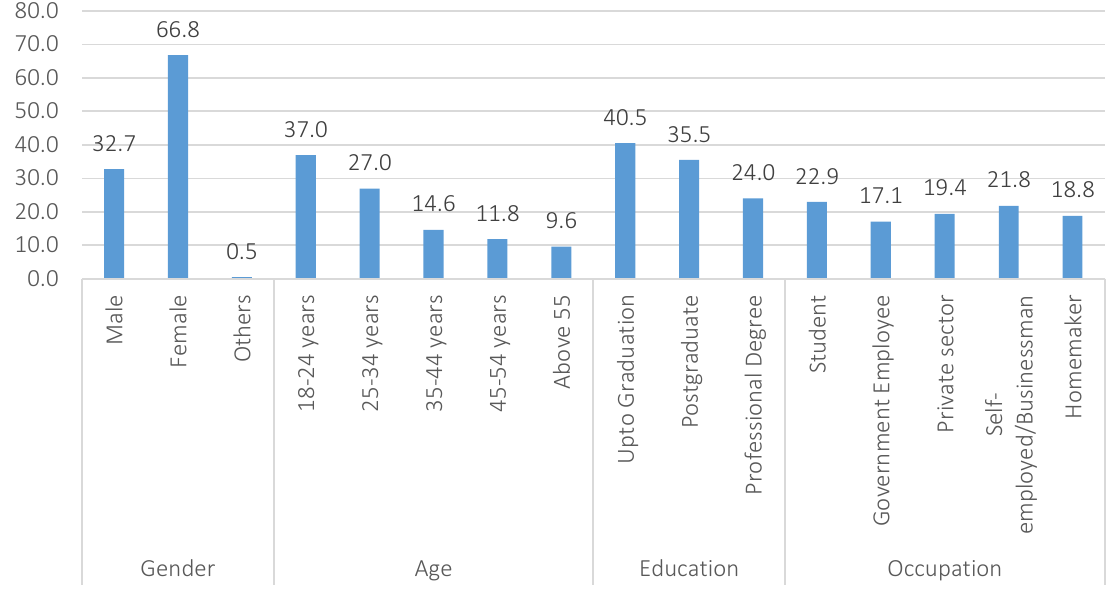
Figure 1. Demographic analysis based on gender, age, education, and occupation